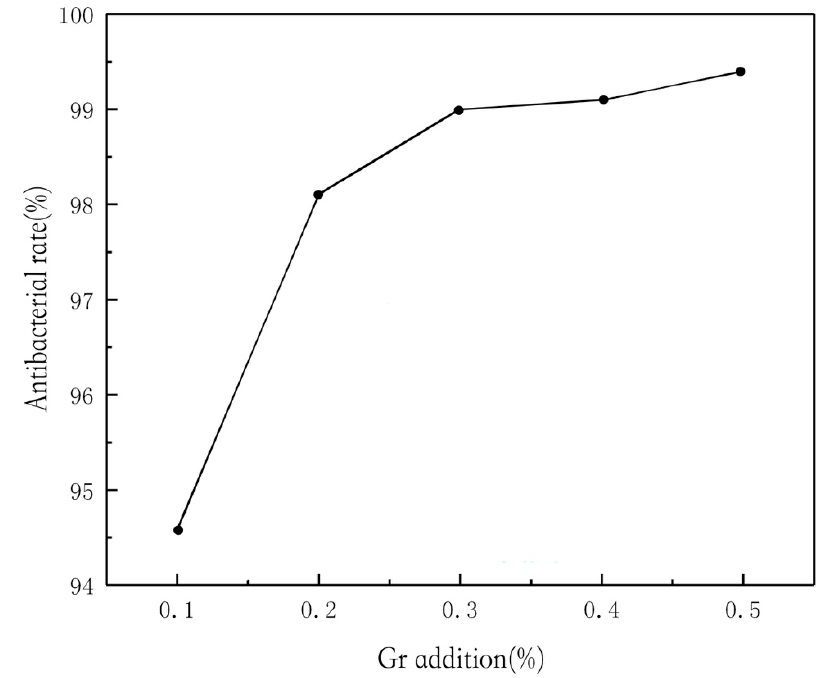
Figure 6. Effect of Gr addition on the antimicrobial activity of CS/Gr modified bamboo fiber fabrics (CGBFs).